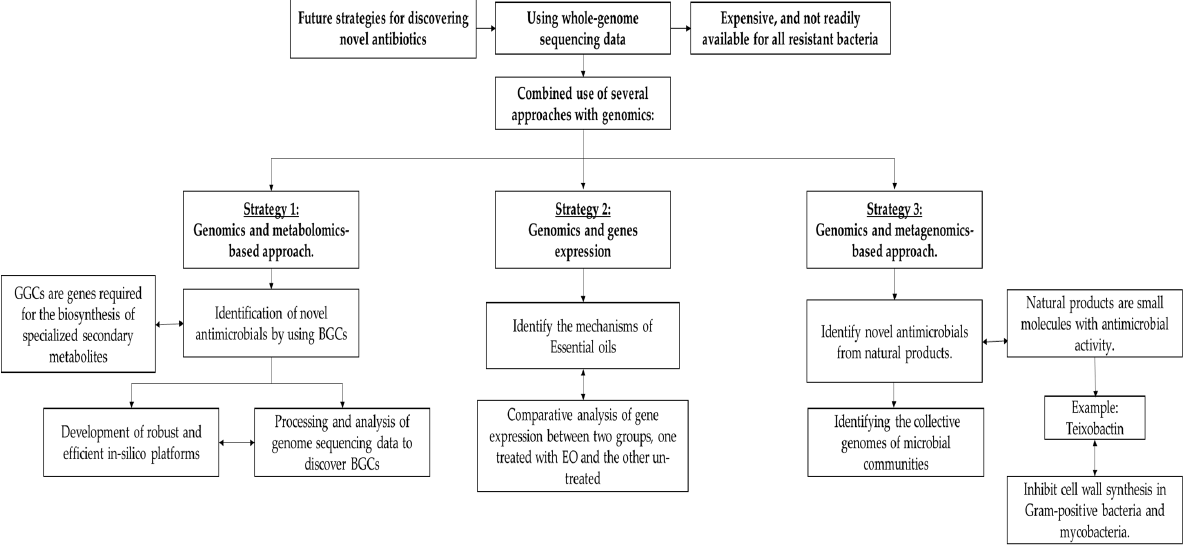
Figure 5. Combination of using several approaches with genomics for discovering novel